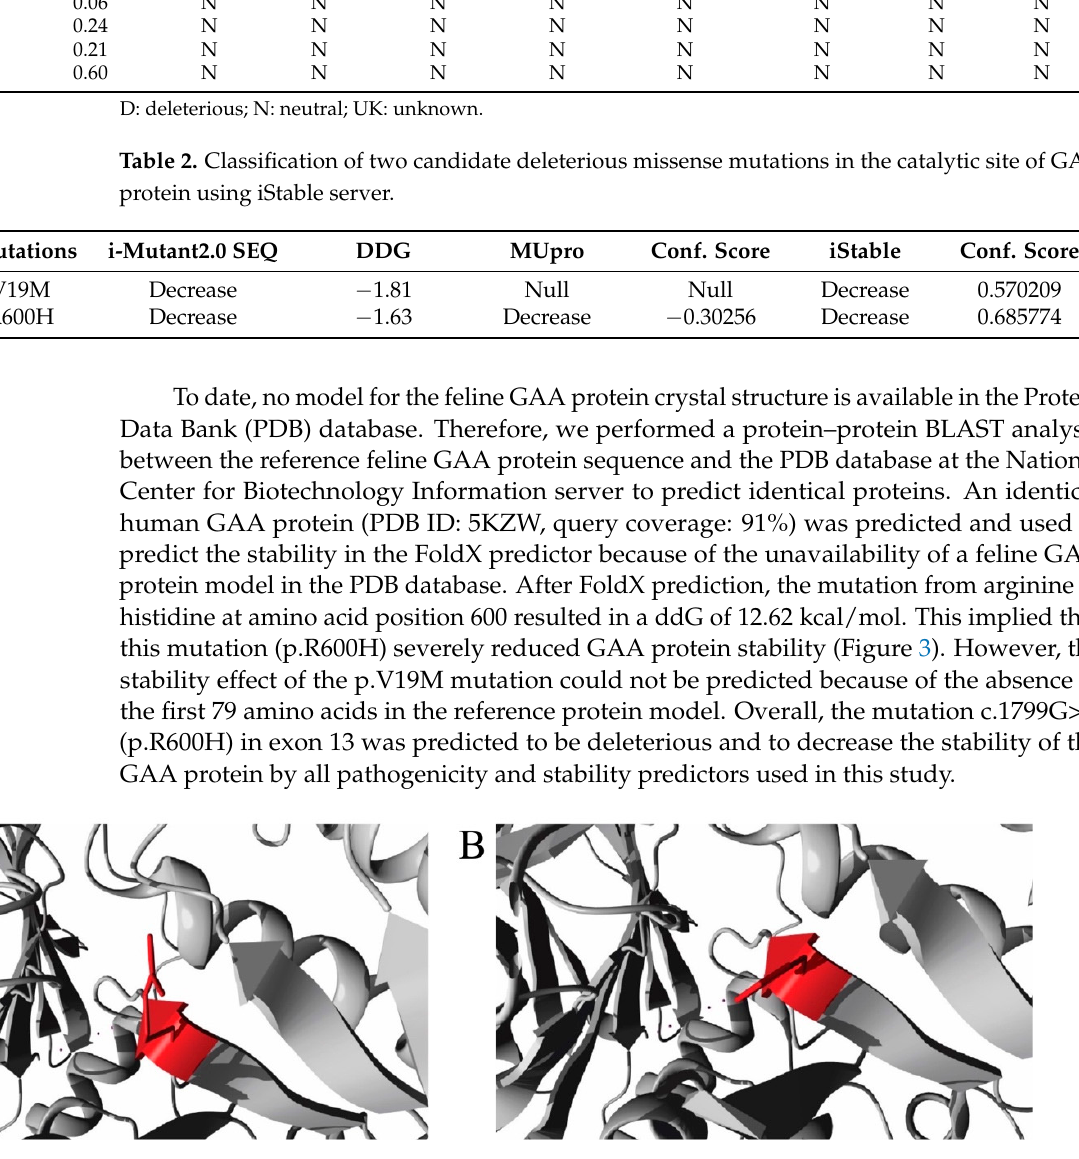
Table 1. Analysis of missense mutations in the catalytic site of the GAA protein using the SIFT and PredictSNP servers.